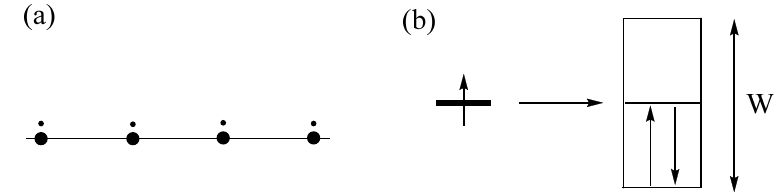
Figure 10. (a) A chain made up of identical atoms with one electron and one orbital. ( b ) The formation of an energy band of the chain (right) from the energy level of an atom (left). With one electron per site, each level of the lower-half of the band is doubly occupied in the one-electron picture.